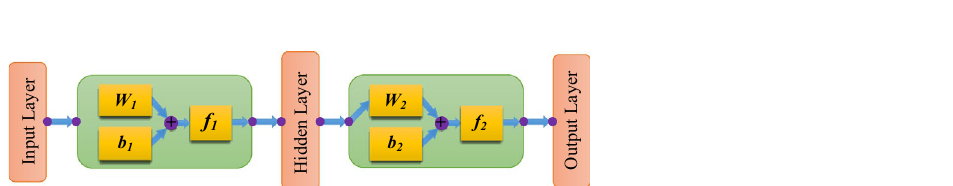
Figure 2. Flow chart of BP neural network (MS Office 2019; www. micro soft. com/ en- us/ micro soft- 365/ get- start ed- with- office-